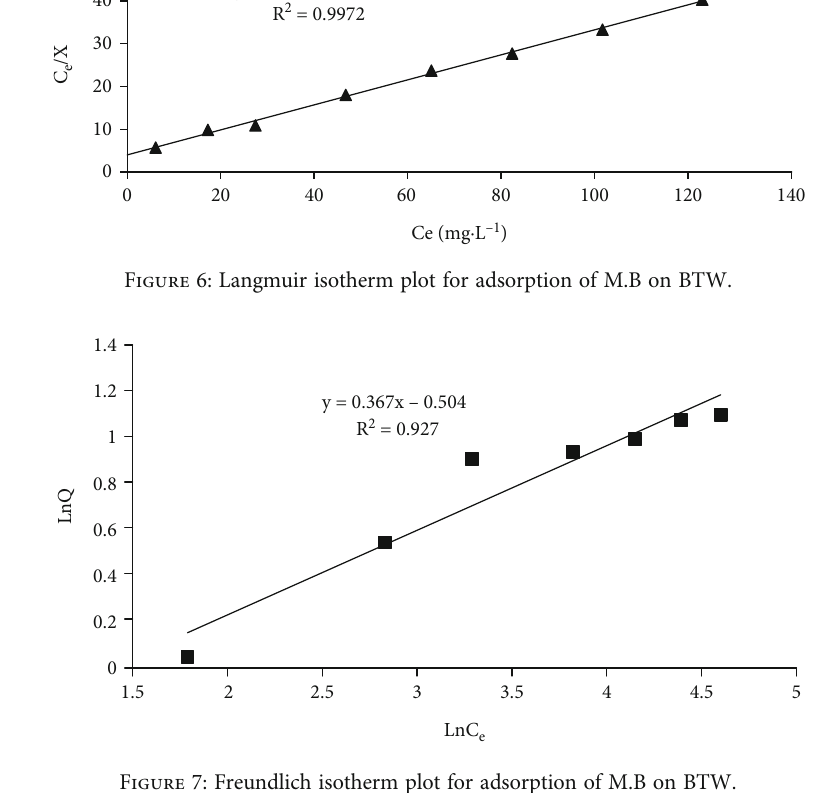
Figure 7: Freundlich isotherm plot for adsorption of M.B on BTW.